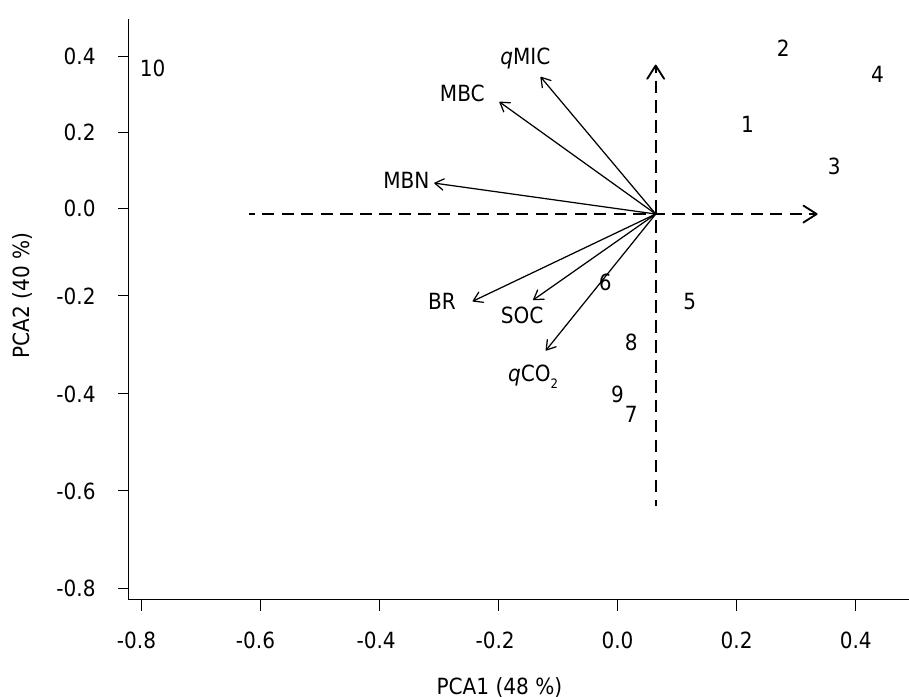
Figure 2. Biplot generated by principal component analysis (PCA) of the biological properties in the 0.00-0.10 m soil layer of the Latossolo Vermelho Amarelo distroférrico (Oxisol) subjected to different uses in Nova Canaã do Norte. MT. 1, 2, 3, and 4: iCLF1 and sampling on the tree row and at 2.5, 5.0, and 10.0 m from this row, respectively; 5, 6, 7, 8, and 9: iCLF3 and sampling on the central row and at 3.0, 6.0, 9.0, and 12.0 m from this row, respectively; 10: degraded pasture. MBC: microbial biomass carbon; MBN: microbial biomass nitrogen; BR: soil basal respiration; q CO 2 : metabolic quotient; SOC: soil organic carbon; and q MIC: microbial